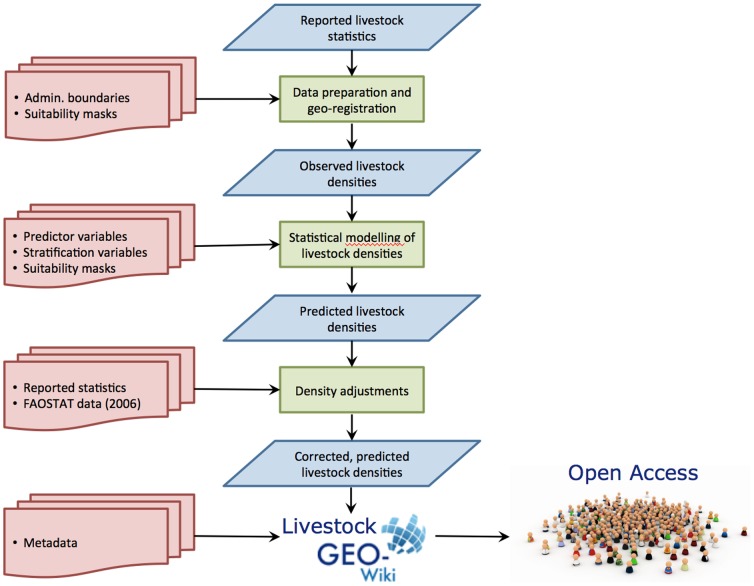
Overall workflow of GLW modelling.